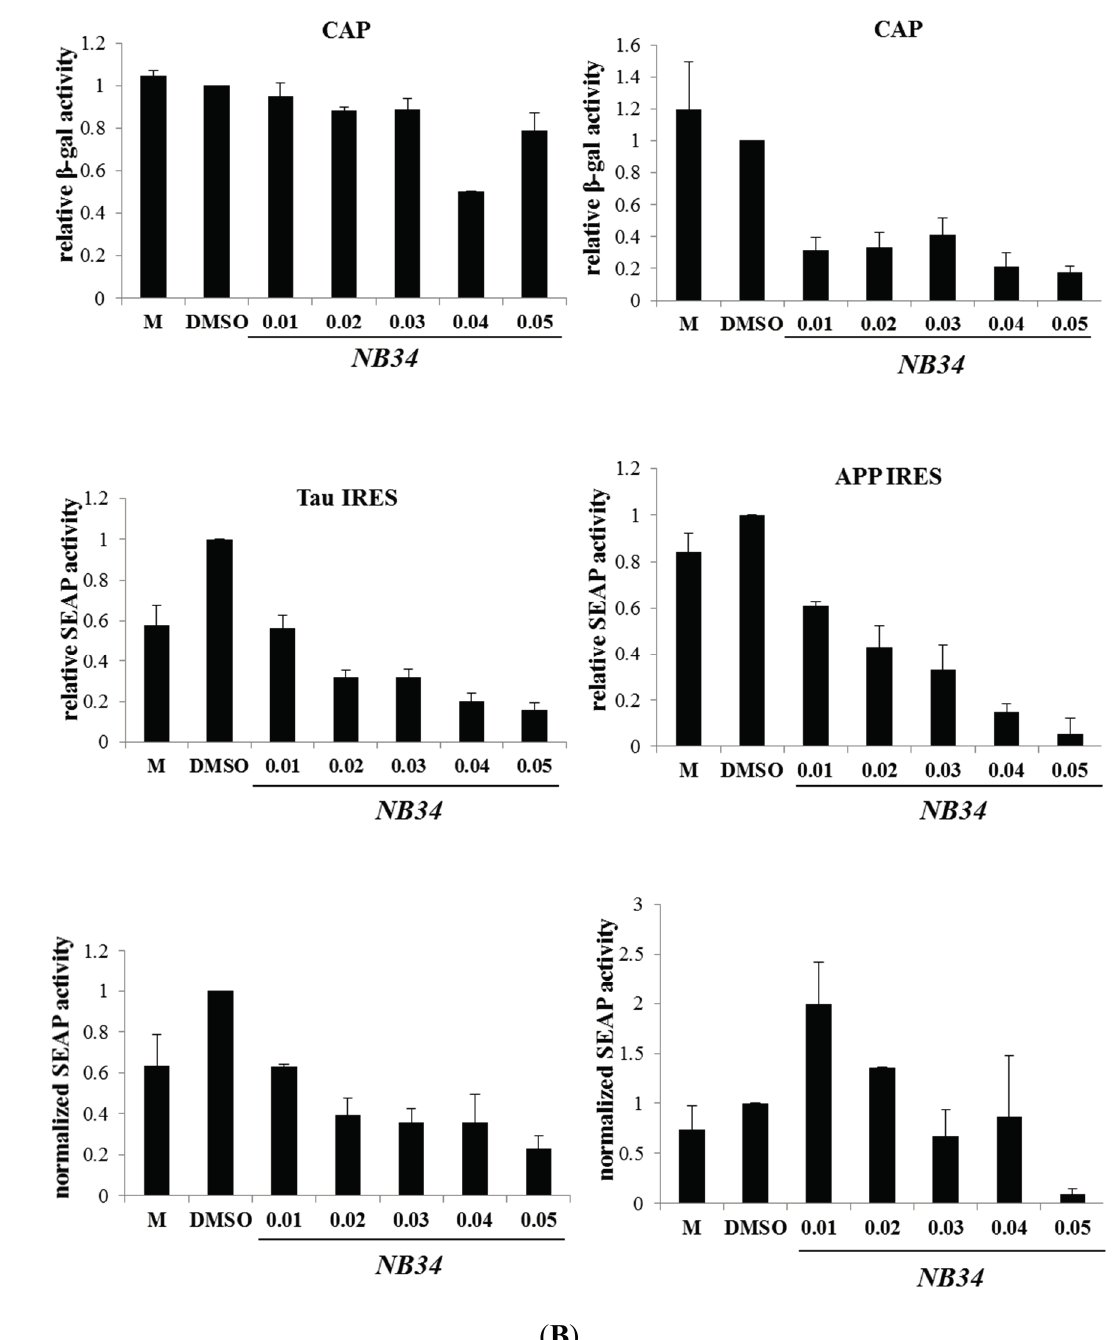
Figure 6. Identification of NB34 as an inhibitor for Tau IRES in N2A cells. ( A ) The N2A cells (~9 × 10 4 cells/well) were seeded onto a 24-well plate prior to transfection. Lipofectamine (1 μ L) was used to transfect the pGS-Tau plasmid DNA (1 μ g) into the neuroblastoma cells. At 24 h post treatment with various preparation (0.05 mg/mL) of Chinese herbs fermented by Lactobacillus spp., ( NB1-92 , and only the NB33-45 are shown) the culture medium from each well was harvested, cells were lysed and subsequent SEAP and β -galactosidase assays were made, respectively; ( B ) The dose dependence of NB34 on translation activity of APP IRES and Tau IRES in N2A cells. M, 0.25 μ M